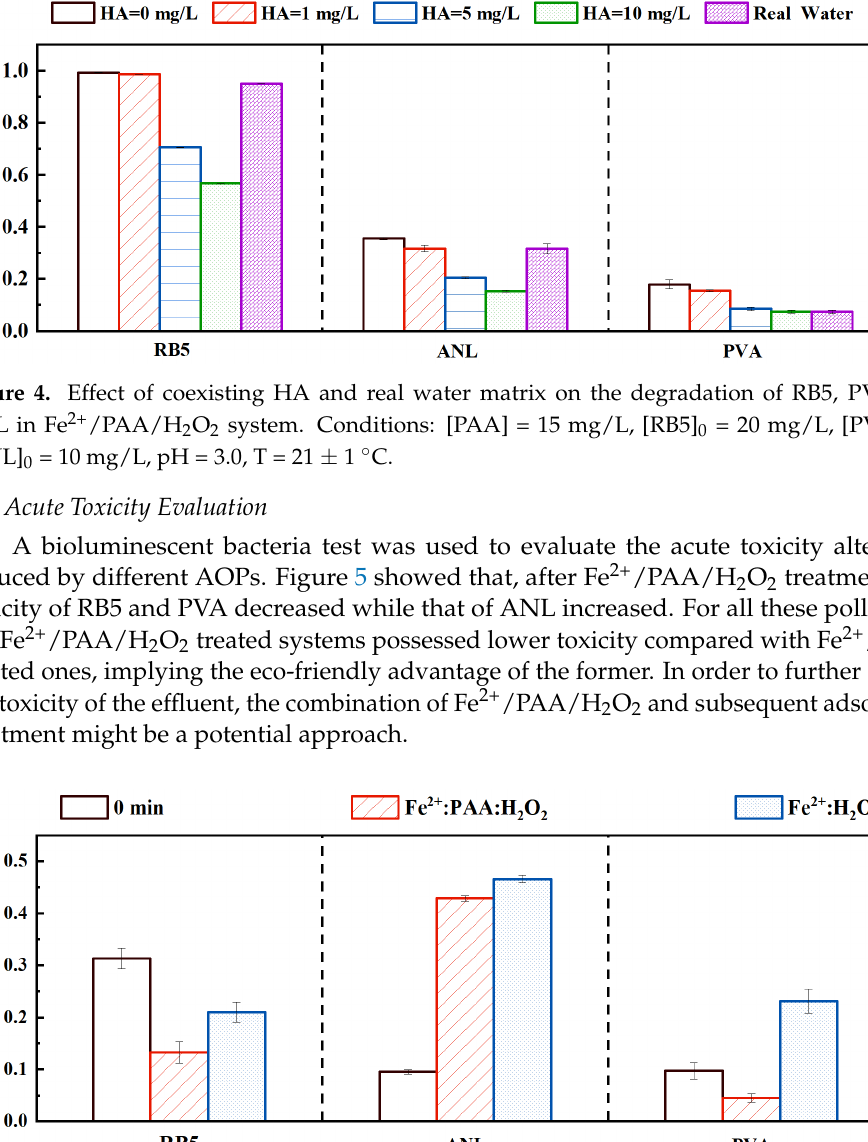
Figure 5. Acute toxicity alteration towards bioluminescent bacteria induced by different AOPs. Con- ditions: [PAA] = 15 mg/L, pH = 3.0, T = 21 ± 1 °C. RB5: ([RB5] 0 = 20 mg/L, Fe 2+ : PAA:H 2 O 2 = 1.1 mg/L:15 mg/L:5 mg/L, Fe 2+ : H 2 O 2 = 1.1 mg/L:5 mg/L); PVA or ANL: ([PVA] 0 or [ANL] 0 = 10 mg/L, Fe 2+ : PAA:H 2 O 2 = 2.2 mg/L:15 mg/L:5 mg/L, Fe 2+ : H 2 O 2 = 2.2 mg/L:5 mg/L).